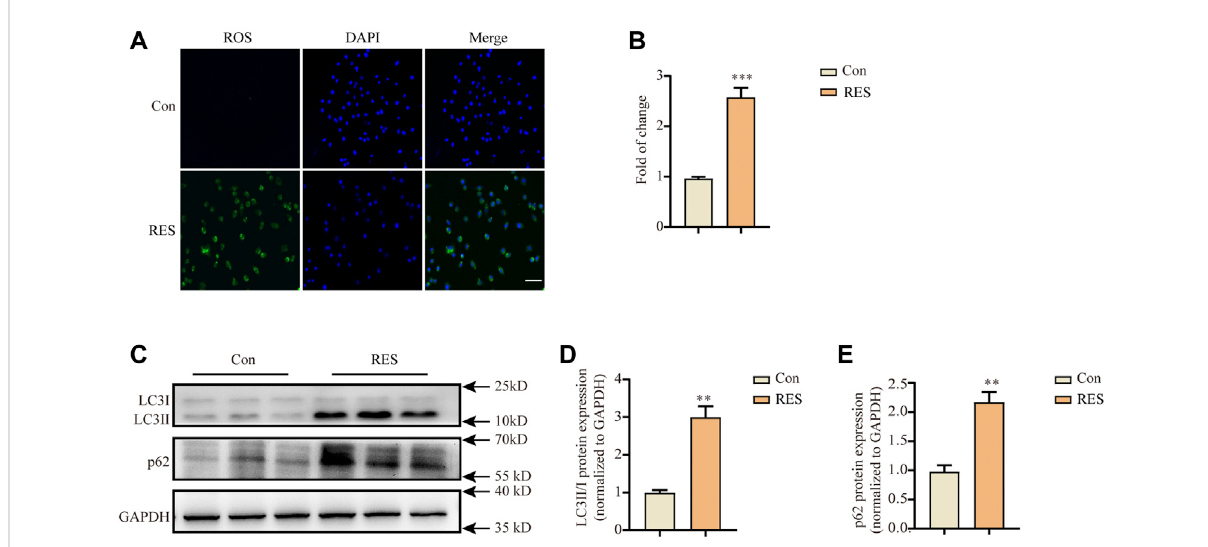
FIGURE 2 Reserpine treatment in SH-SY5Y cells induced the accumulation of intracellular ROS and autophagic dysfunction. (A,B) Representative fl uorescenceimagesforintracellularROSstainedwithDCFH-DAprobeshowedthatreserpineinducedsigni fi cantaccumulationofintracellularROS, which wassuppressedby theantioxidants, NAC andPBN; scale bar:100 μ m. (A,B) arerepresentativeand statistical plots,respectively( n = 3for each group, student t-test, * p < 0.05, *** p < 0.001 vs. control). (C) Representative western blotting images for LC3 and P62 expression. (D) The ratio of LC3-II/LC3-I protein expression increased ( n = 3 for each group, student t-test, ** p < 0.01 vs. control). (E) The levels of p62 protein expression increased ( n = 3 for each group, student t-test, ** p < 0.01 vs. control). All data are expressed as mean ± SEM; Con, control; RES, reserpine; NAC, N -acetyl-L-cysteine; PBN, N -tert-butyl- α